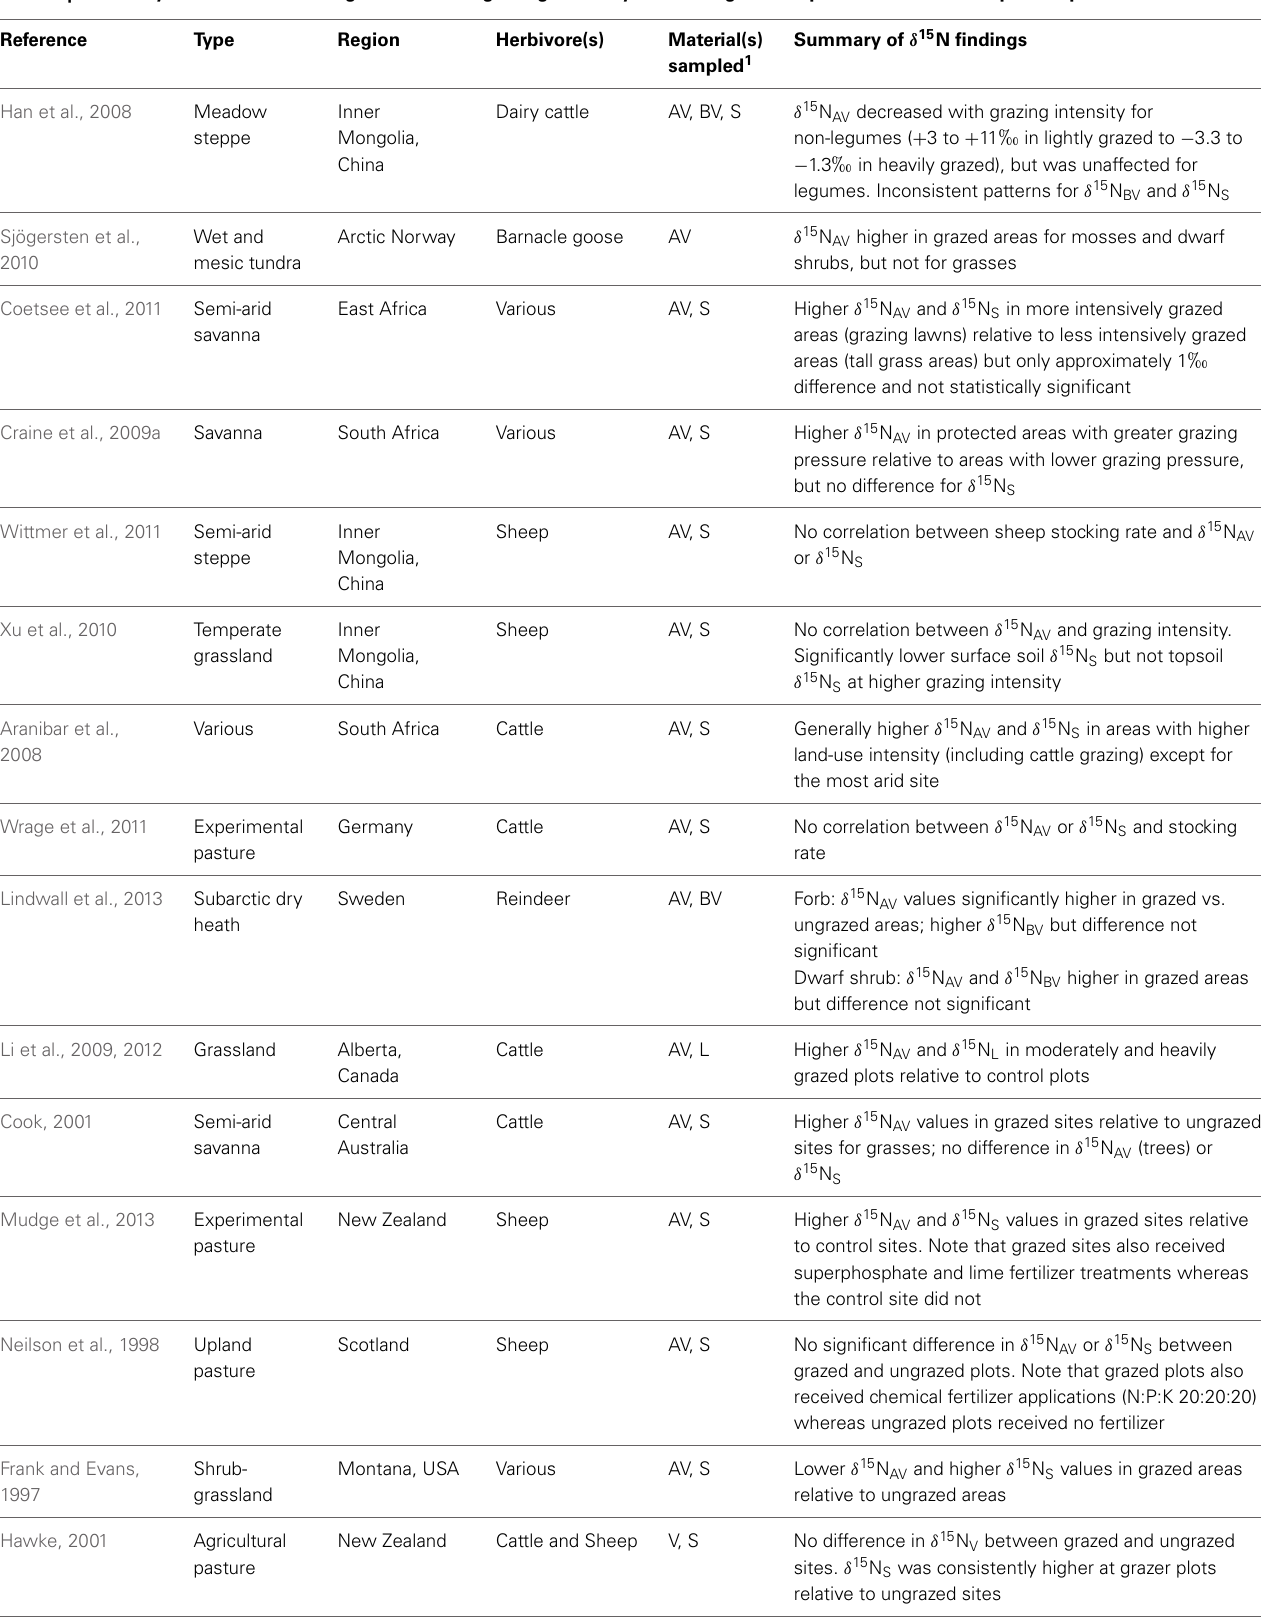
Table 2 | Summary of studies examining the effects of grazing intensity or stocking rate on plant and soil N isotopic compositions.